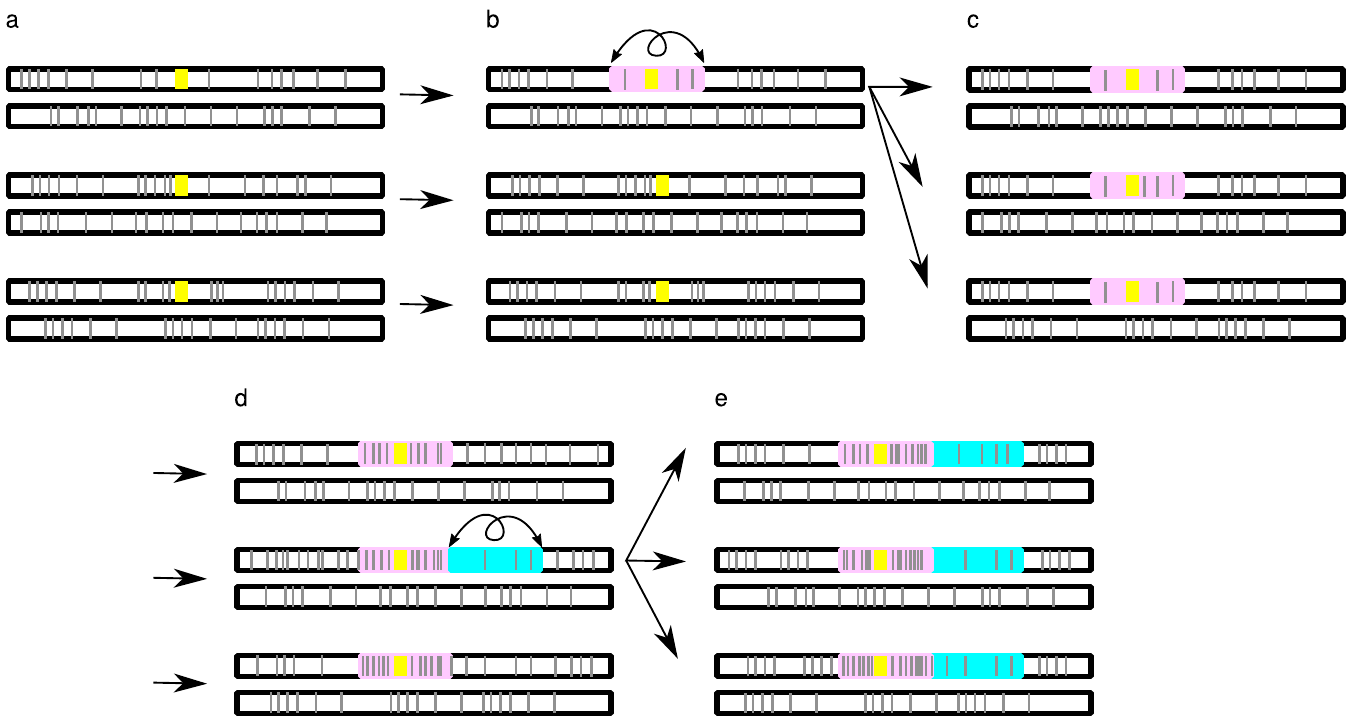
Fig 1. Schematic representation of the processes modeled by Jay and colleagues. Consider chromosomes with a sex-determining locus (yellow) and several deleterious mutations (gray bars). For the sake of simplicity, only 1 pair of chromosomes of 3 individuals of the heterogametic sex (XY males or ZW females) is shown. (a) The chromosomes all carry some deleterious mutations. (b) A “lucky” inversion (pink) captures fewer mutations than the population average and also includes the sex- determining locus. (c) This inversion gets fixed in the population and starts accumulating mutations. (d) As recombination is completely impossible in this region, it accumulates mutations and carries more than other regions in the genome. However, adjacent or (partially) overlapping, a new “lucky” inversion can arise (cyan). (e) This lucky inversion can become fixed as well, thereby creating a new evolutionary stratum.